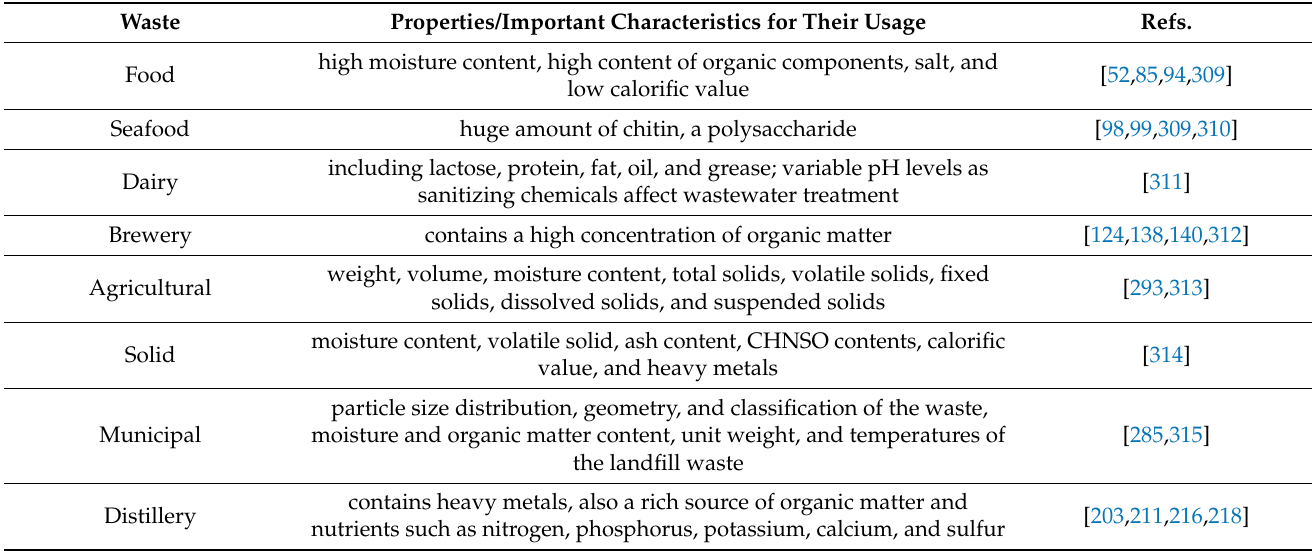
Table 1. Waste properties and characteristics for MFC